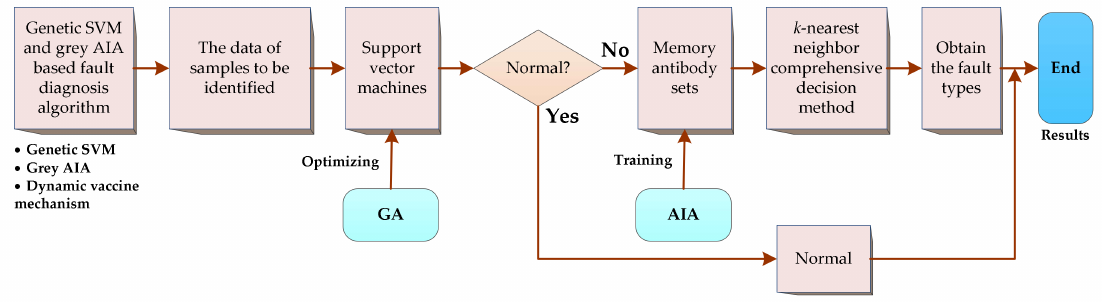
Figure 10. The genetic SVM and grey AIA-based transformer fault diagnosis flow chart presented in [72].